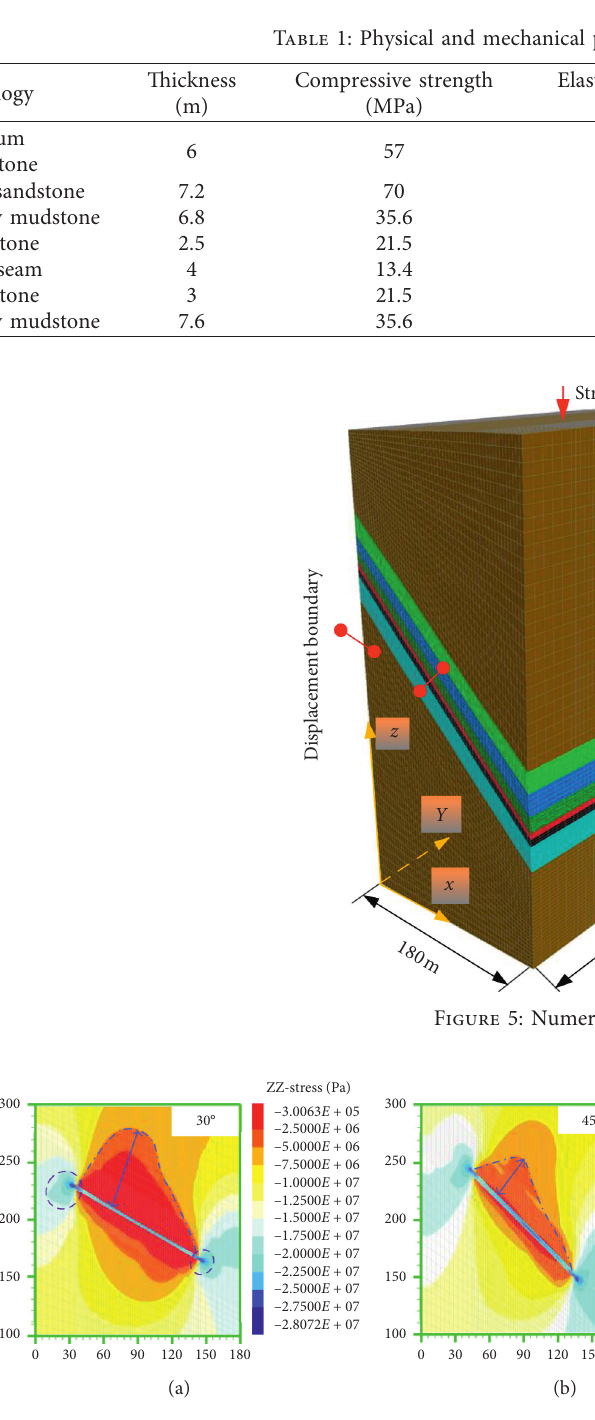
Figure 6: Vertical stress distribution characteristics of different coal seam dip